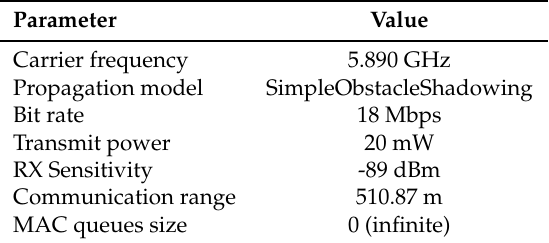
Table 2. PHY/MAC